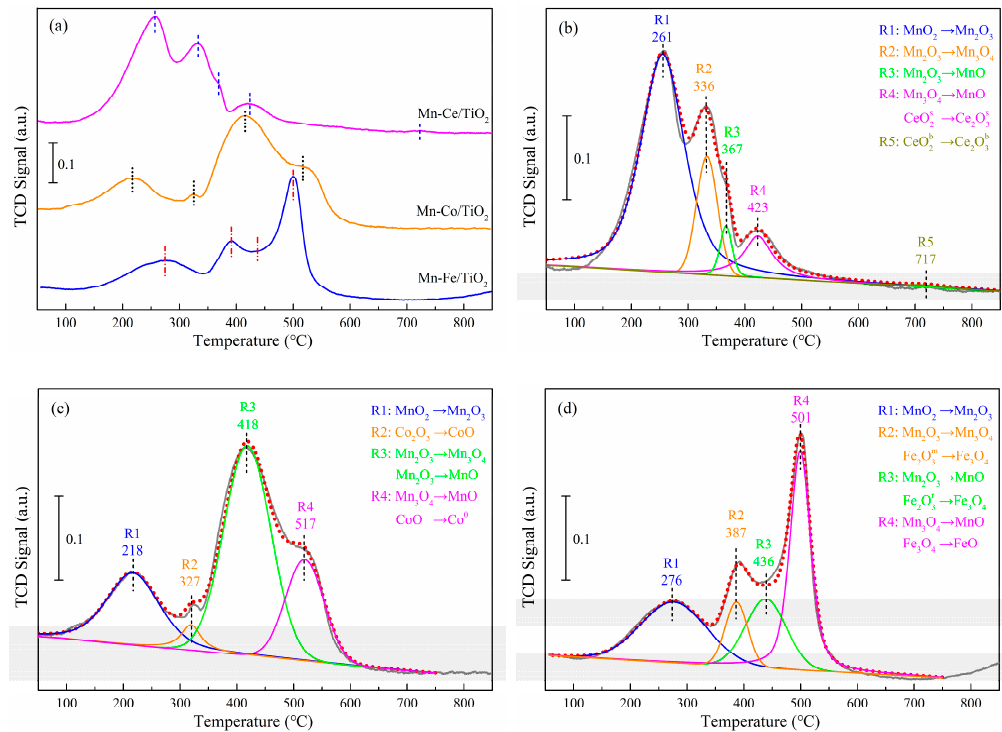
Figure 6. H 2 -TPR profiles of Mn-based bimetallic nanocatalysts: ( a ) Total H 2 -TPR curves; ( b ) multi-peaks Gaussian fitting for Mn − Ce/TiO 2 nanocatalyst; ( c ) multi-peaks Gaussian fitting for Mn − Co/TiO 2 nanocatalyst; and ( d ) multi-peaks Gaussian fitting for Mn − Fe/TiO 2 nanocatalyst. Table 3. H 2 -TPR quantitative analysis of Mn-based bimetallic nanocatalysts.